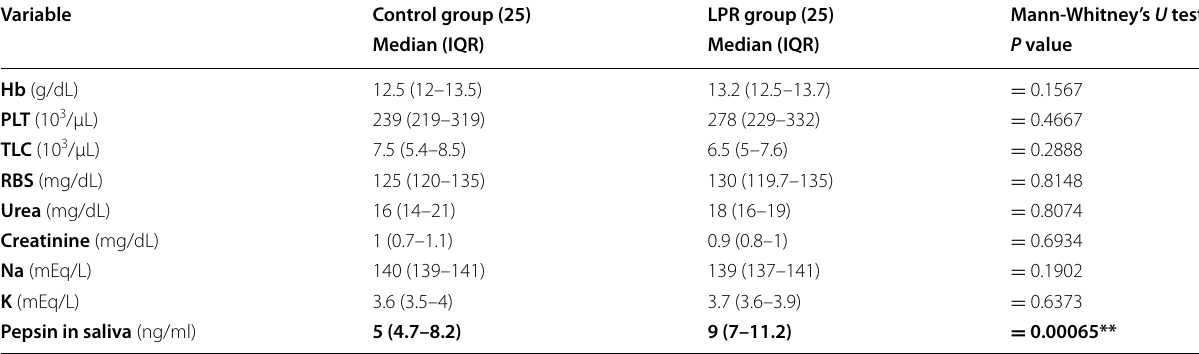
Hb Hemoglobin, PLT Platelets, TLC Total leucocytic count, RBS Random blood sugar, Na Sodium, K